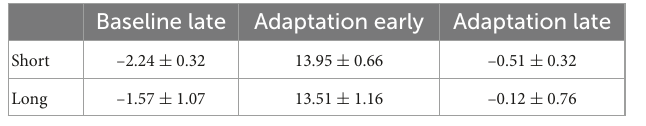
TABLE 1 Movement during the three periods.